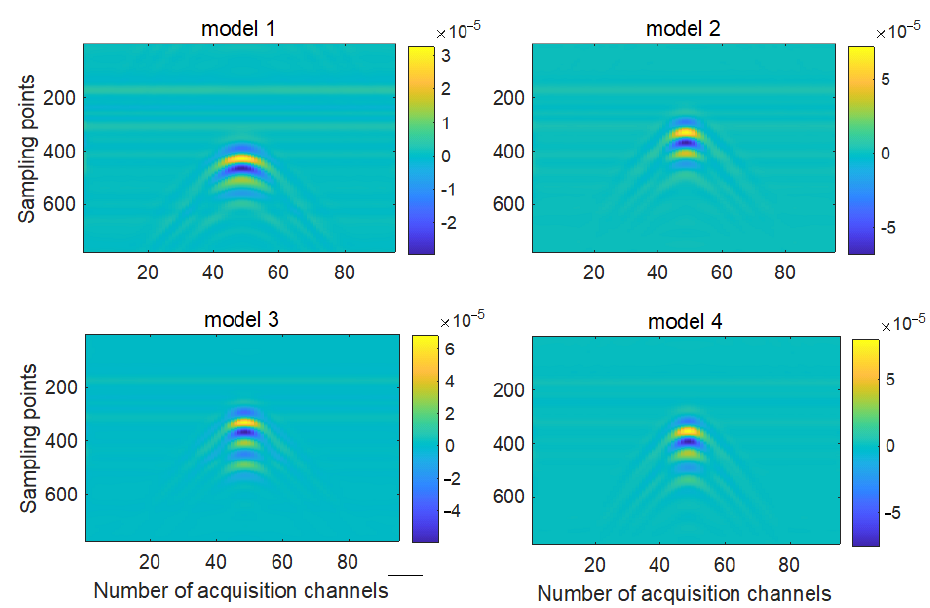
Figure 11. Wavelet prediction of derived models.